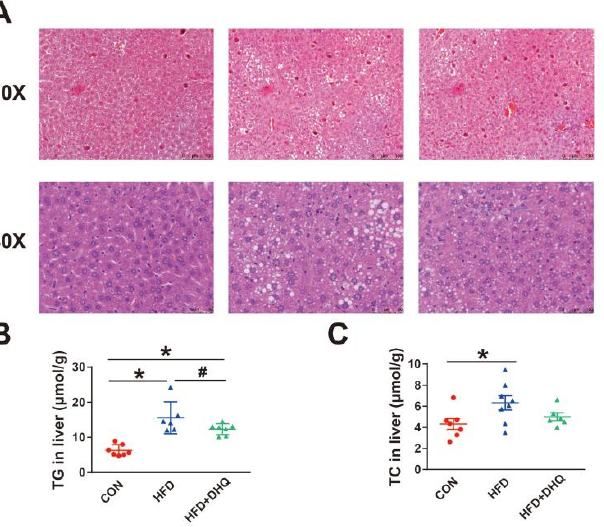
Figure 3. Effects of DHQ on lipid deposition in livers of mice. ( A ) H&E staining images of hepatic tissue; ( B ) TG level; and ( C ) TC level. Data were expressed as the mean ± SEM. * p < 0.05 vs. CON group, # p < 0.05 vs. HFD